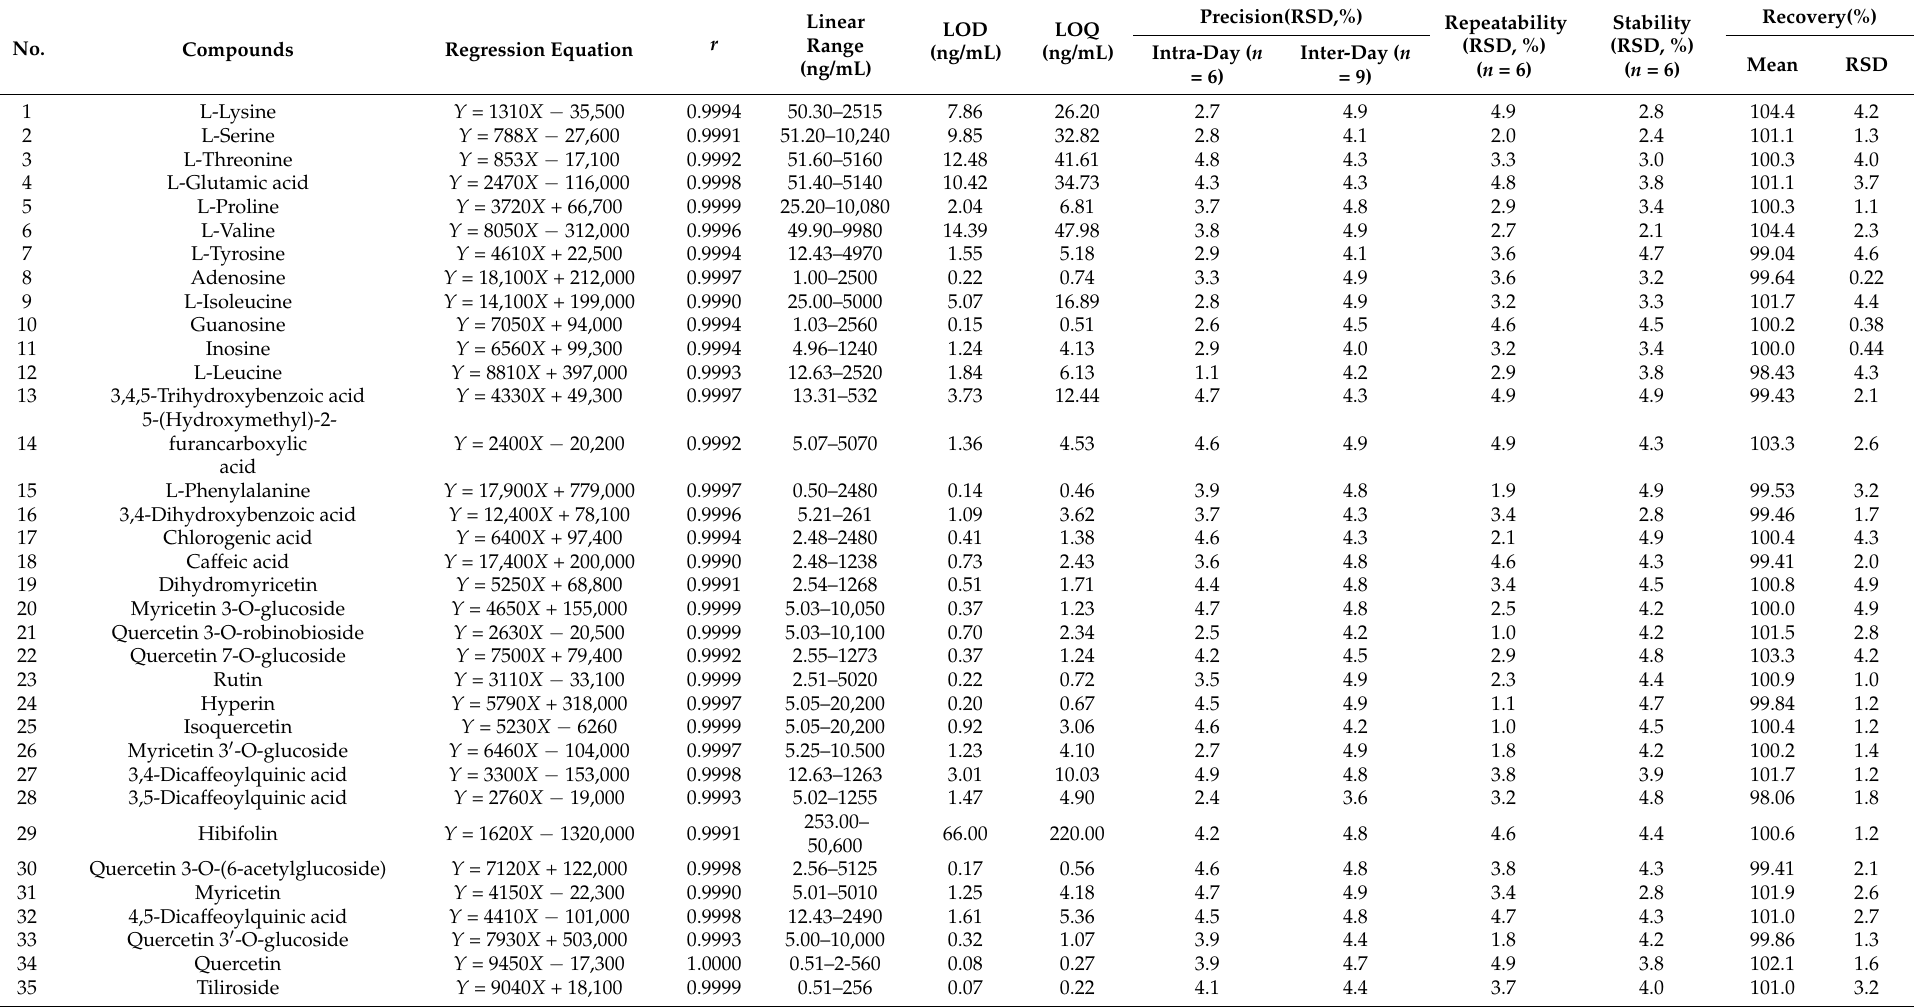
Table 2. Regression equation, limits of detections (LODs), limits of quantifications (LOQs), precision, repeatability, stability, and recovery of the 35 investigated constituents.